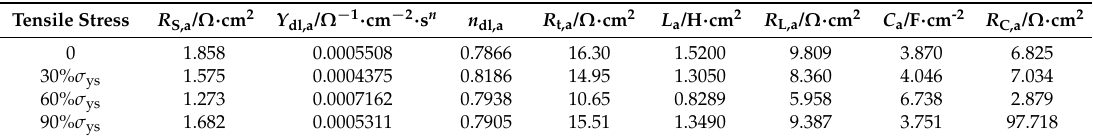
Table 4. EIS parameters of X80 steel obtained by fitting the EIS curves of X80 steel measured at +60 mV (vs. OCP) in 3.5 wt% NaCl aqueous solution with saturated CO 2 under plastic tensile stress at 30 °C. Tensile